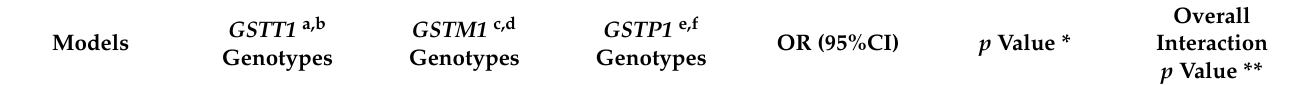
Table 3. Associations between GST genes and binary detectable blood Al concentrations (BAlCs) based on logistic regression models that include a two-way gene*gene interaction (N =